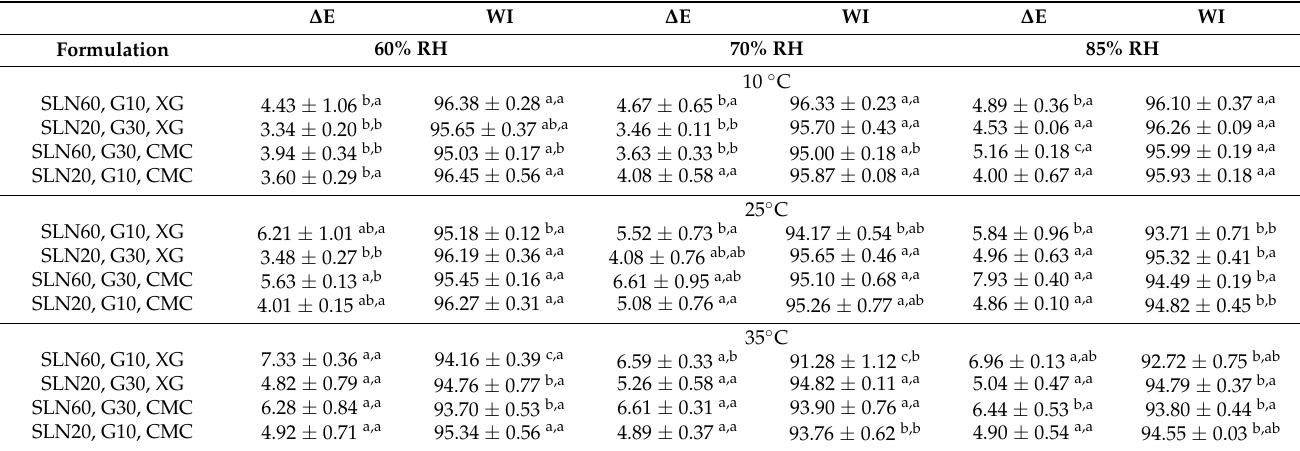
Table 5. Total color difference ( ∆ E) and whiteness index (WI) of edible films under different stor- age